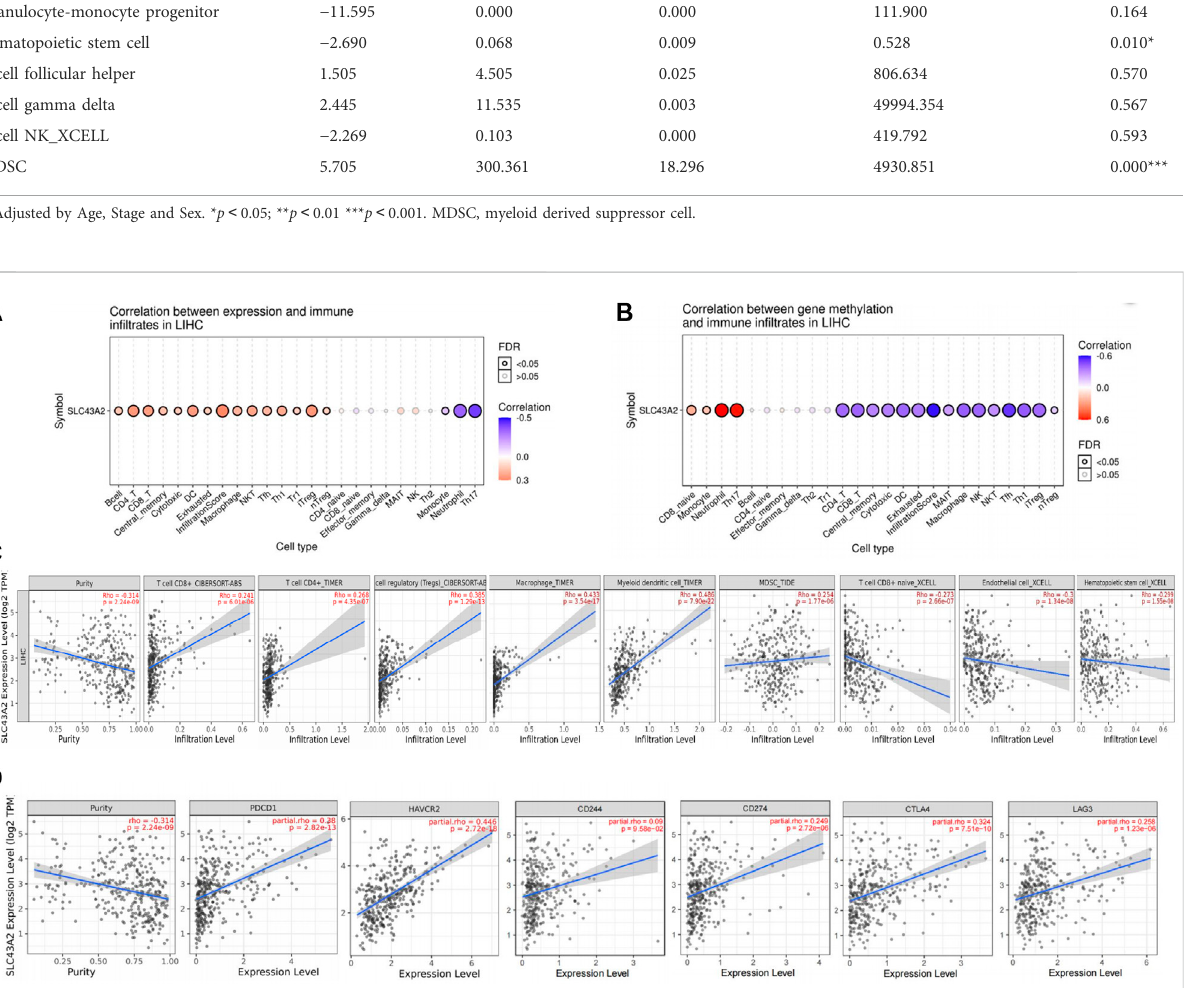
FIGURE 4 CorrelationofSLC43A2expressionwithimmunein fi ltrationlevelinLIHC.CorrelationsbetweenSLC43A2expression (A) ,SLC43A2methylation (B) andthe relativeabundancesof24immunecellsbyusingGSCAdataset.BubblesizearecorrelatewithFDRsigni fi cance.BlackoutlineborderindicatesFDR ≤ 0.05,FDR: the false discovery rate. (A, B) . Correlation of SLC43A2 expression with immune in fi ltration level in LIHC using TIMER2 dataset (C) . Correlation of SLC43A2 expression with the abundance of PDCD1, TIM3(HAVCR2), CD244, CD274, CTLA4, and LAG3 in LIHC using TIMER2 dataset (D)